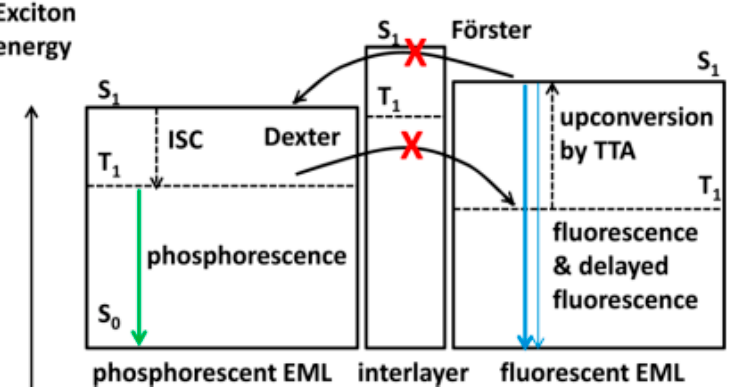
Figure 26. Exciton energy diagram of the WOLEDs and the possible methods of decay of singlet and triplet excitons. Reprinted with permission from Reference [216]. Copyright (2016) American Chemical Society.